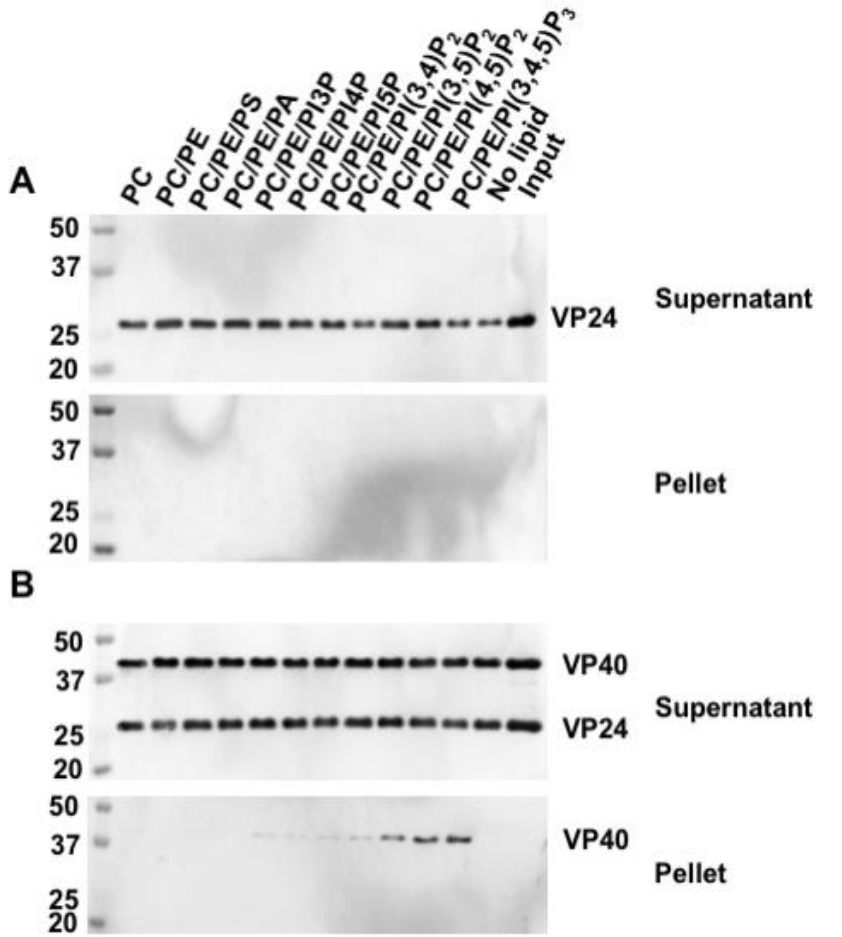
Figure 3. VP24 did not bind to lipids in the presence of eVP40 by protein–liposome sedimentation assay. In this assay, 1 µ g of purified VP24 ( A ) or the mixture of 1 µ g of purified VP24 and 1 µ g of eVP40 ( B ) was (were) incubated with various liposomes for 45 min at room temperature (RT). The protein was detected by anti-His-alkaline phosphatase antibodies in the supernatant and liposome pellet after centrifugation. VP24 alone or along with eVP40 was not associated with any liposome pellet. eVP40 showed up in the expected liposome pellet.